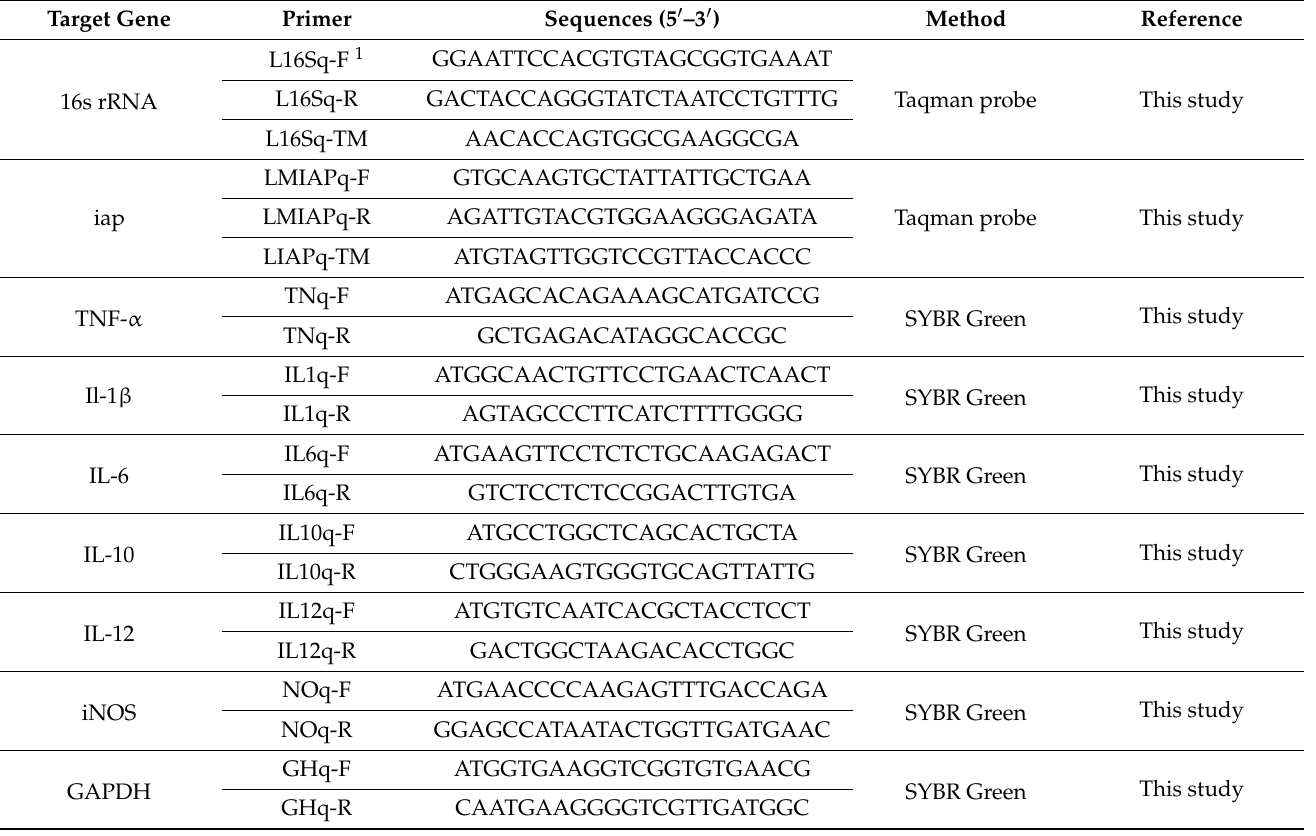
Table 2. Primer or probe sequences of the targeted genes in real-time